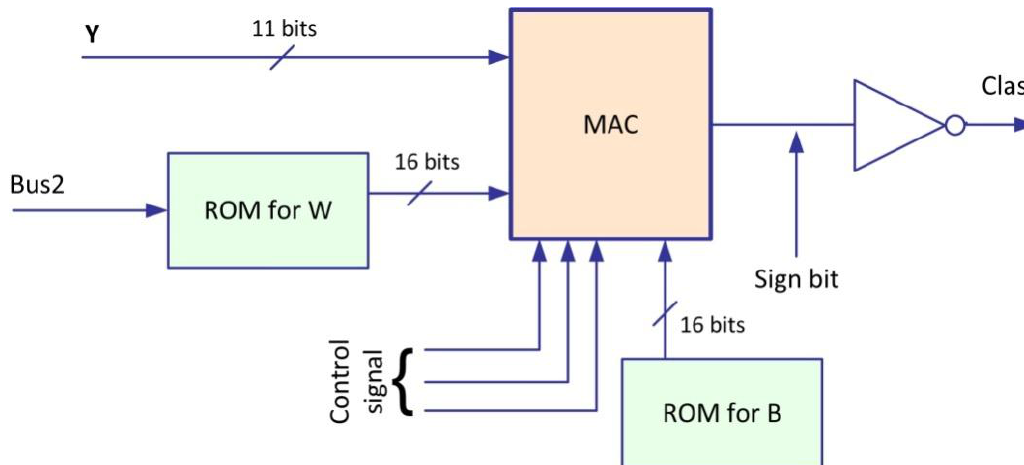
Figure 12. Structure of the output layer